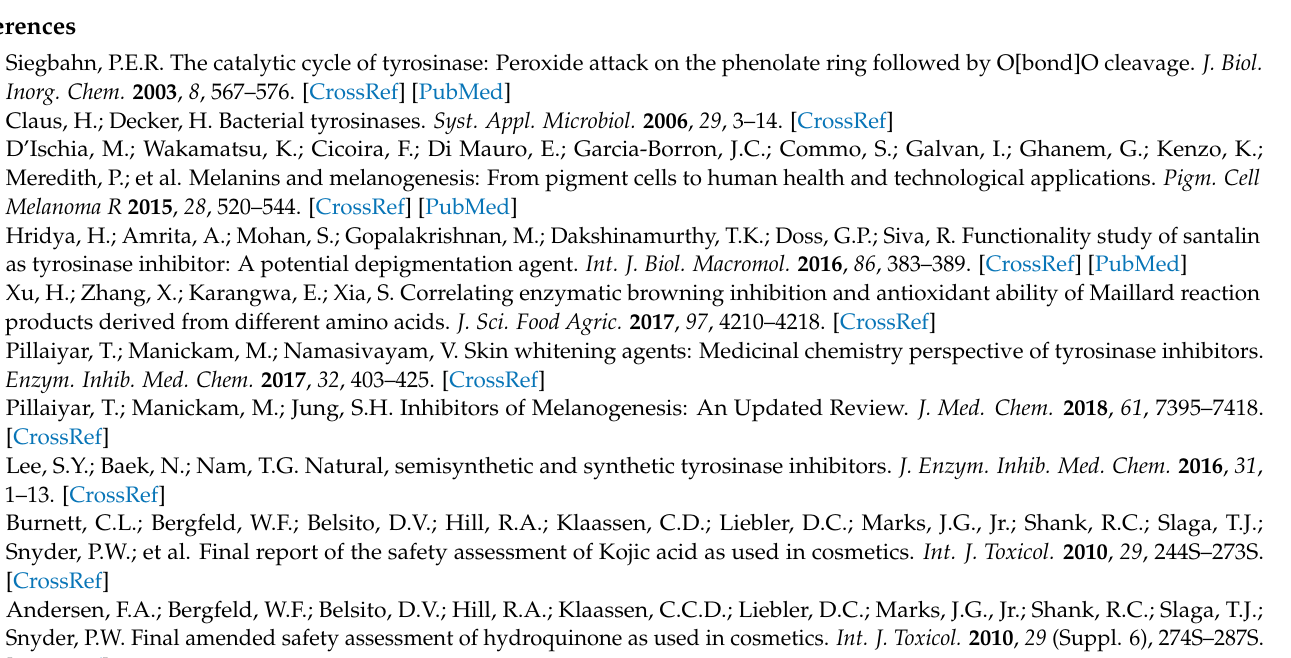
(TSC 12); Section 2. Enzyme